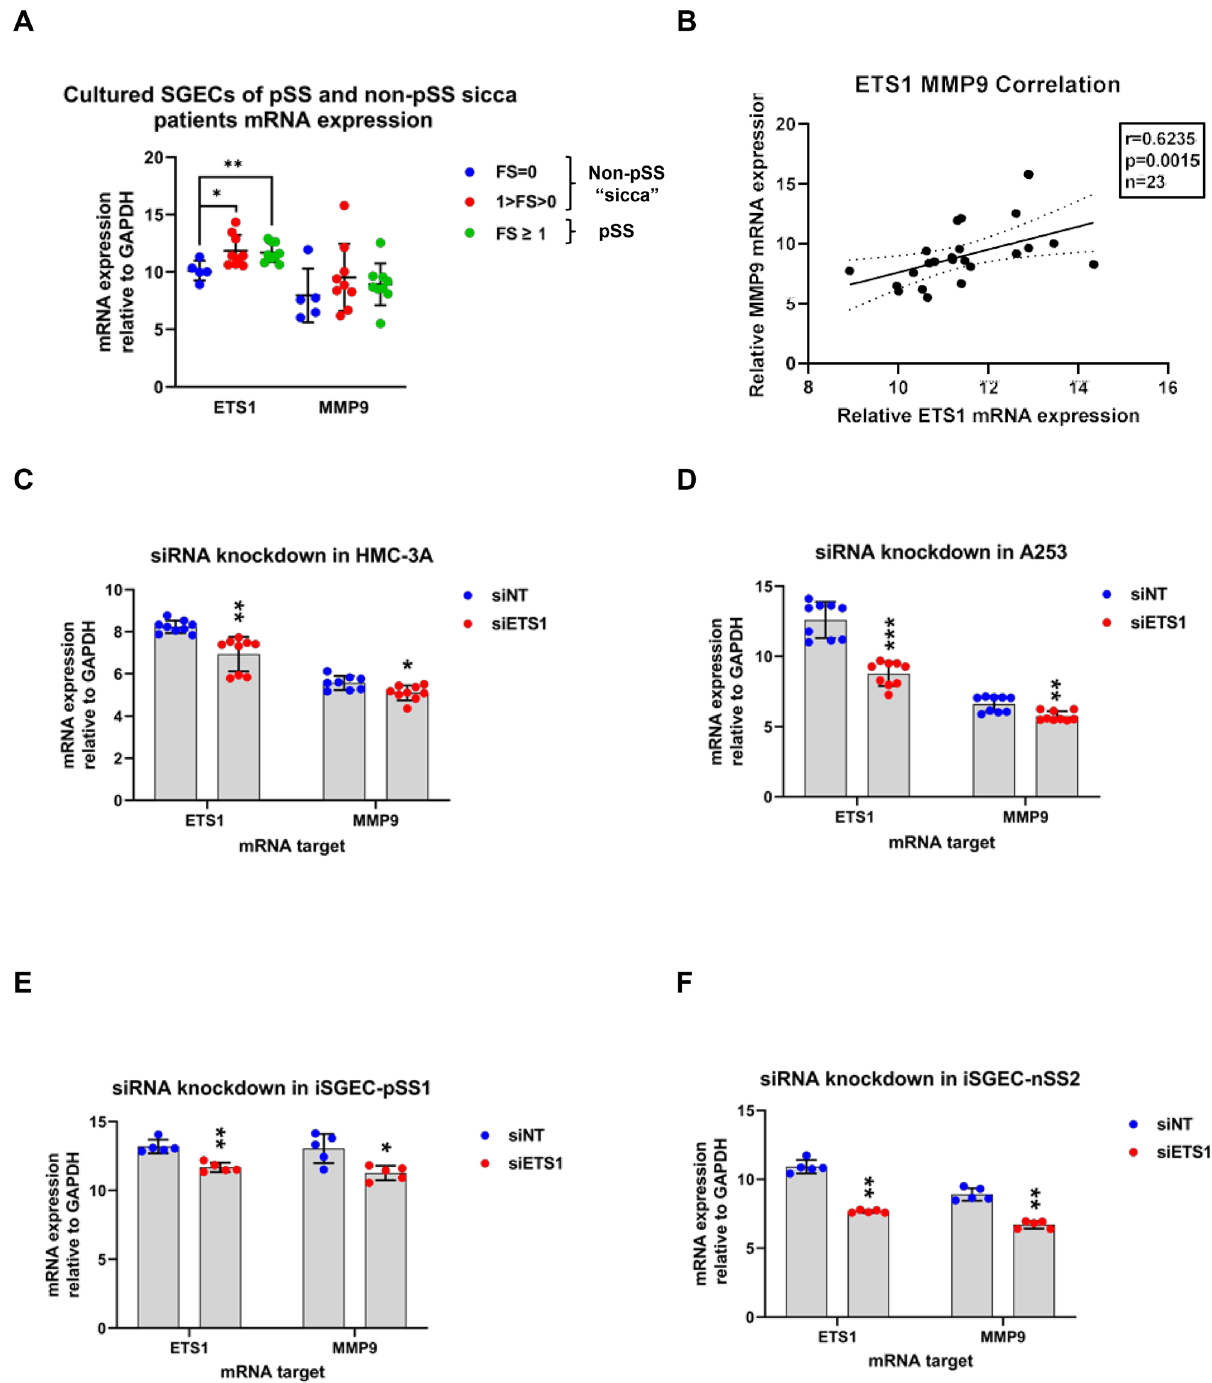
Figure 1. Effects of ETS1 siRNA mediated knock down on MMP9 mRNA expression in salivary gland derived cell lines. Explant SGEC cultures were obtained from pSS(FS ≥ 1) (n = 9), non-pSS(10) (n = 9), and non-pSS(FS = 0) n = 5) patients. ( A ) qRT-PCR expression of ETS1 and MMP9 in primary SGEs was normalized to GAPDH and compared to FS = 0 by Mann–Whitney U-test. Error bars represent mean (+/−) standard deviation (SD). SGECs of pSS (FS ≥ 1) over express both ETS1 (p = 0.007) and MMP9 (p > 0.05) compared to non-pSS (FS = 0) patients. LikepSS (FS ≥ 1), non-pSS (1 < FS > 0) SGECs over expressed ETS1(p = 0.0120) compared to the FS = 0 group. ( B ) Spearman’s rank correlation coefficient ( rho ) was used to assess correlations among ETS1 and MMP9 mRNA expression in primary SGECs (n = 23). ETS1 expression correlated with MMP9 (r = 0.6235, p = 0.0015, n = 23) ( B ). mRNA expression of ETS1 and MMP9 was determined in the salivary gland derived cell linesHMC-3A ( C ), A253 ( D ), iSGEC-pSS1 ( E ), and iSGEC-nSS2 ( F ), 48 h post-transfection with siRNA targeting ETS1byqRT-PCR. Knockdown of ETS1 (siETS1) were compared to a non- targeting (siNT) control. qRT-PCR mRNA expression was normalized to the housekeeping gene GAPDH. Knockdown of ETS1 consistently led to a reduction of MMP9 mRNA expression. Data are presented as the mean +/− standard deviation (SD) (n = 6): *p < 0.05, **p < 0.01, ***p <